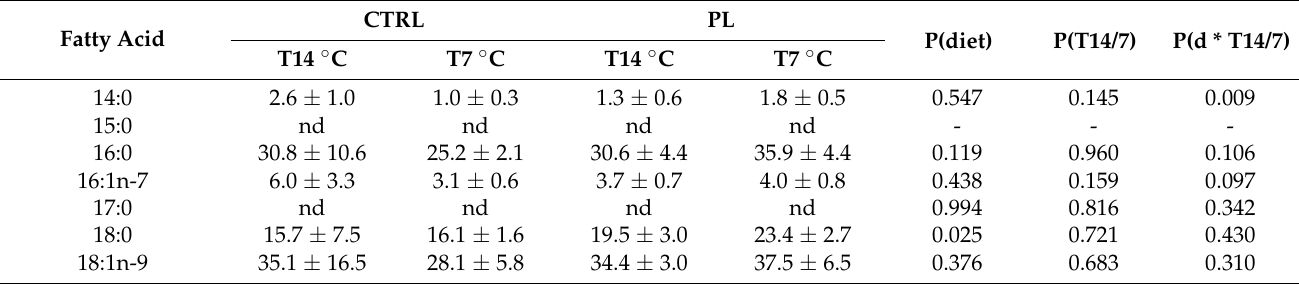
Table 5. FA composition (in µ g mgdw − 1 ) in brain of meagre fed experimental diets CTRL and PL and kept at 14 ◦ C (T14 ◦ C) or challenged at 7 ◦ C (T7 ◦ C) (mean ± SD, n =